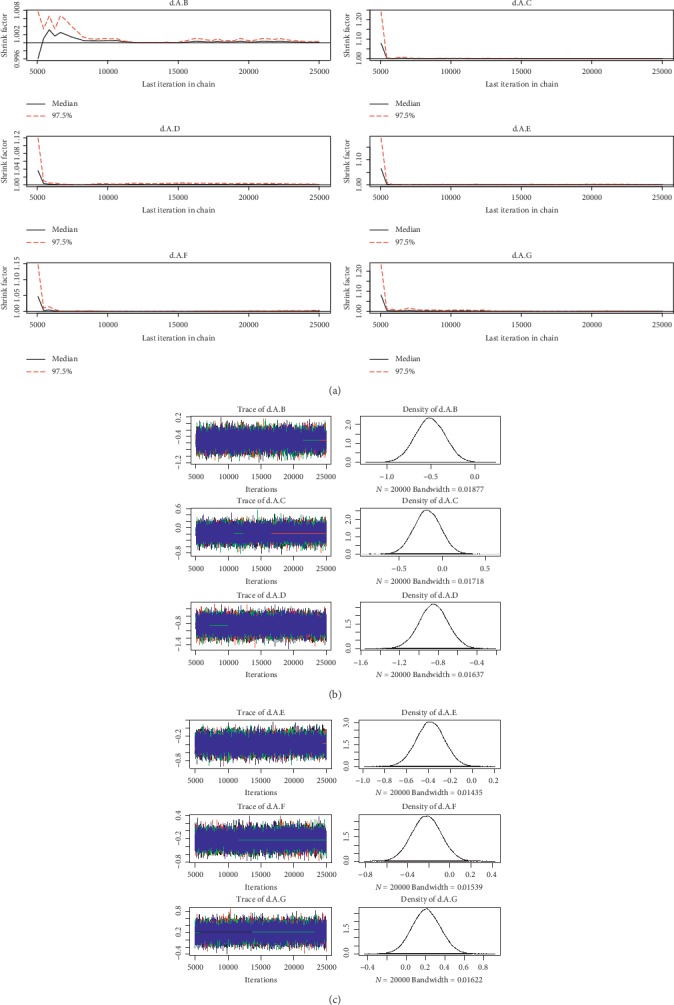
Brooks-Gelman-Rubin diagnostic plot and density plot for the safety of the comparison among different treatments of patients with normal renal function.